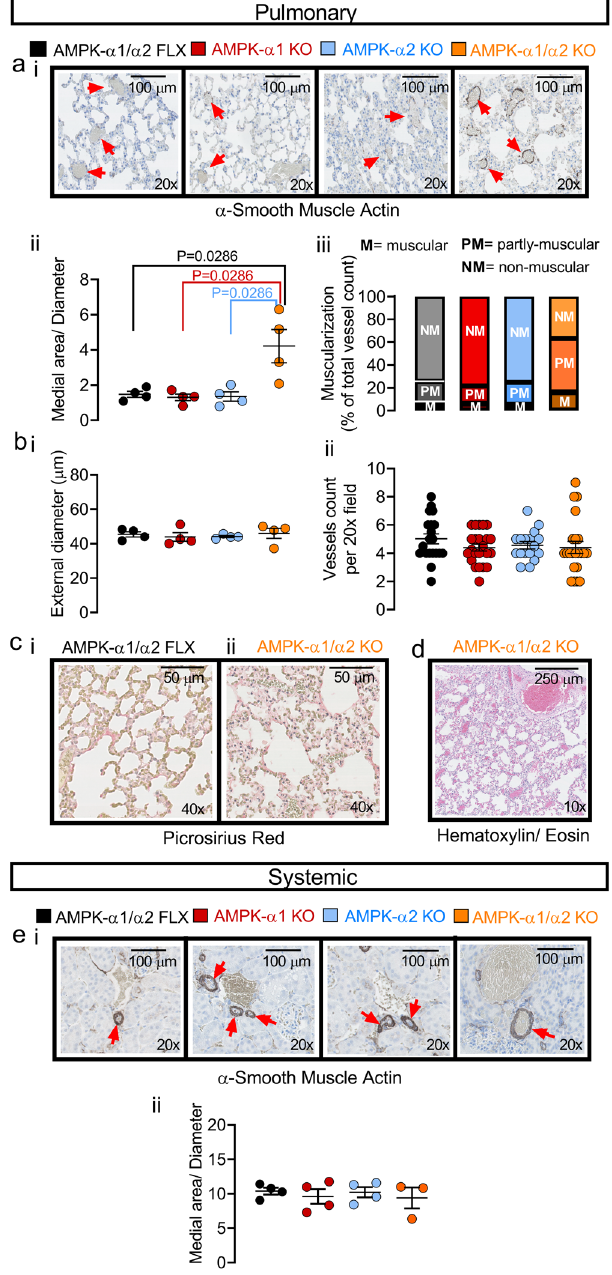
Fig. 3 | AMPK- α 1/ α 2 deletion precipitated remodeling of pulmonary arterial but not systemic arterial system. a Representative images of lung slices from terminalsamples stained for (i) α -smooth muscle actin, togetherwith scatter plots of (ii) medial area corrected by diameter and (iii) degree of muscularisation for all pulmonary arteries analysed for AMPK- α 1/ α 2 knockouts (AMPK- α 1/ α 2 KO; n =4 mice, average of 22 – 39 arteries per mouse, 7 fi elds per mouse) after death at 7 – 10 weeks, and age-matched AMPK- α 1/ α 2 fl oxed (AMPK- α 1/ α 2 FLX, n=4 mice, average of 30 – 39 arteriespermouse,7 fi eldsper mouse), AMPK- α 1KO( n =4mice, average of 25 – 37 arteries per mouse, 7 fi elds per mouse) and AMPK- α 2 KO ( n =4 mice, average of 30 – 39 arteries per mouse, 7 fi elds per mouse). b Scatter plots showthemean±SEMforthe(i)externaldiameter( n =4micepergenotype)and(ii) number of vessels found per 20x fi eld for the analysis shown in ( a ) ( n =28 fi elds from n =4 mice per genotype, 7 fi elds per mouse). Images of ( c ) picrosirius red staining and ( d ) Hematoxylin – Eosin staining of lung slices show the absence of parenchymal/alveolar remodeling and the lack of lung oedema, respectively. e (i) representative images of renal slices stained for α -smooth muscle actin, together with (ii) plots of the medial area corrected by diameter analysed for AMPK- α 1/ α 2 KOs ( n =4 mice, average of 20 – 34 arteriesper mouse, 4 fi eldspermouse) and age- matched AMPK- α 1/ α 2 fl oxed ( n =4 mice, average of 17 – 30 arteries per mouse, 4 fi eldspermouse),AMPK- α 1KOs( n =4mice,averageof16 – 30arteriespermouse,4 fi elds per mouse) and AMPK- α 2 KOs ( n =3 mice, average of 25 – 28 arteries per mouse,7 fi eldspermouse).Forclarity,onlymeanvaluesarepresentedinpanelaiii. The rest of the panels are expressed as mean±SEM. Statistical signi fi cance was assessed by two-sided unpaired Mann – Whitney ’ s test (aii, bi-ii, eii) or a Friedman test with Dunn ’ s correction for multiple comparisons